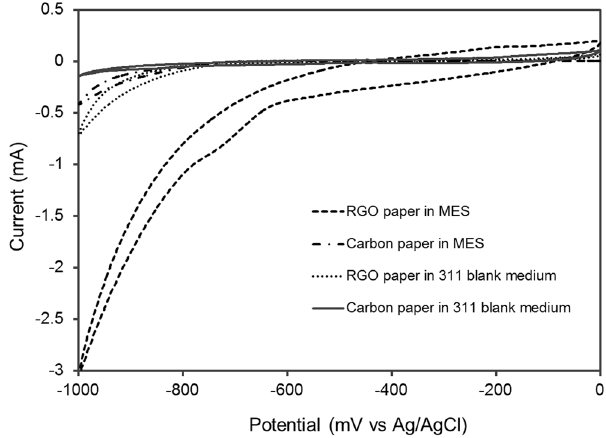
Figure 4. Cyclic voltammograms obtained at a RGO paper cathode or at a carbon paper cathode in S. ovata - driven MES reactor and in sterile blank medium. The potential window was set between − 1.0 V to 0 V versus Ag/AgCl at a scan rate of 1 mV s − 1